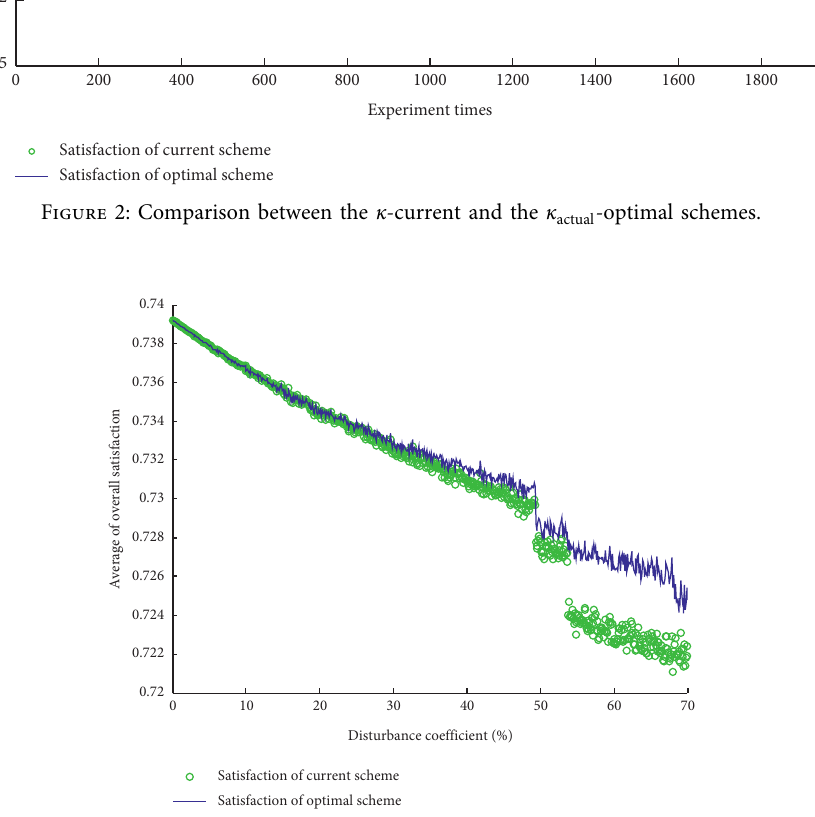
Figure 3: Relationship between the gap and the disturbance